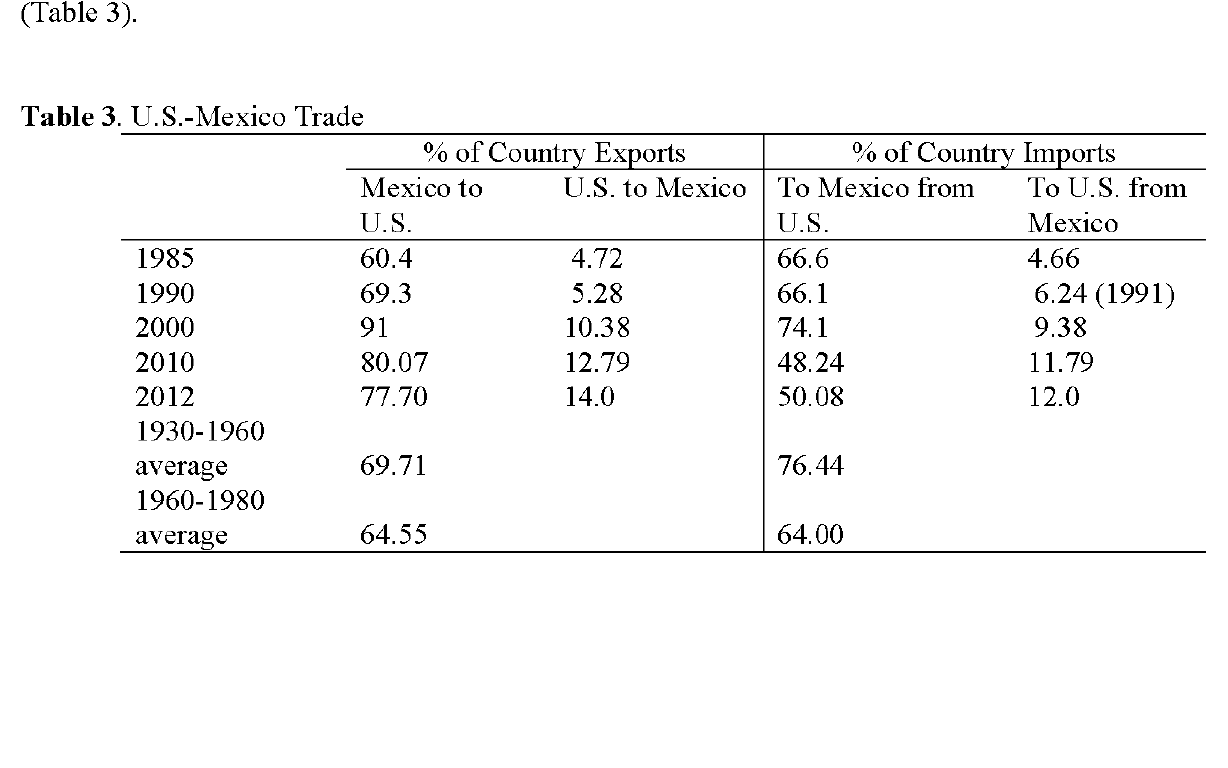
Table 3. U.S.-Mexico Trade